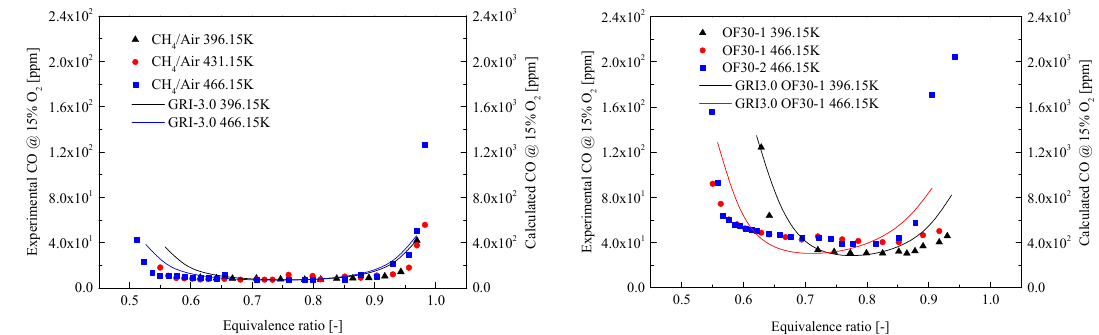
Figure 14. Dependence of CO concentration upon equivalence ratio for CH 4 /air and OF30 flames. The modelled CO emissions are compared with the experimental data. A single perfectly stirred reactor (PSR) reactor and the GRI-3.0 mechanism were used.